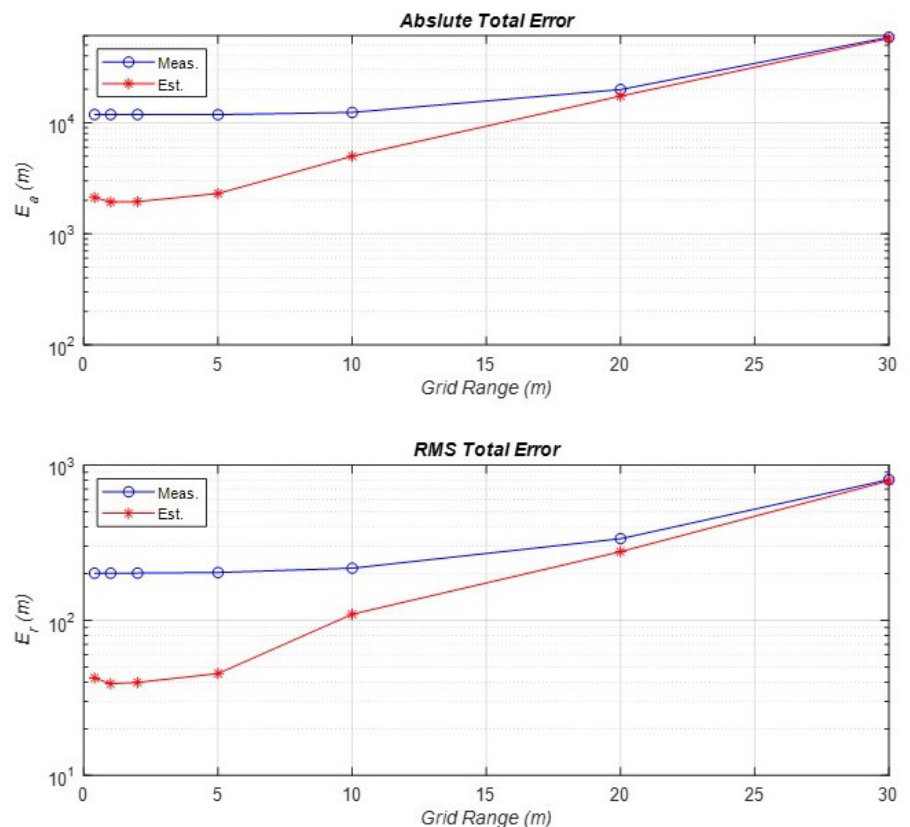
Figure 9. Variation in the absolute and RMS total measured errors (blue lines), and the absolute and RMS total estimated errors (red lines) for different grid ranges at a constant beam angle without external